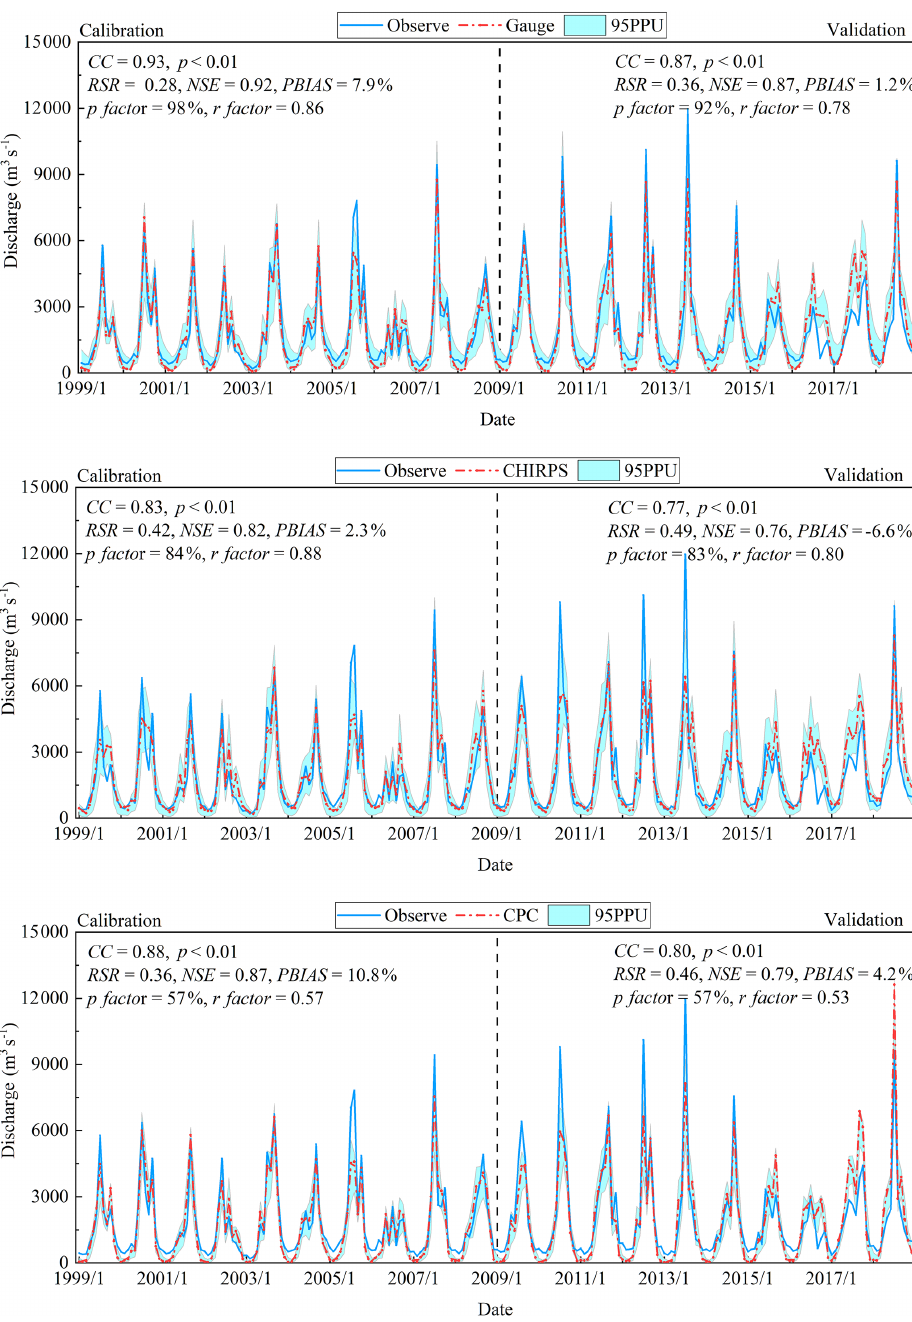
Figure 9. Observed and simulated discharges at the outlet of the JRW at a monthly scale using precipitation inputs of Gauge, CHIRPS, and CPC, respectively. Please note that the date in this figure is given as